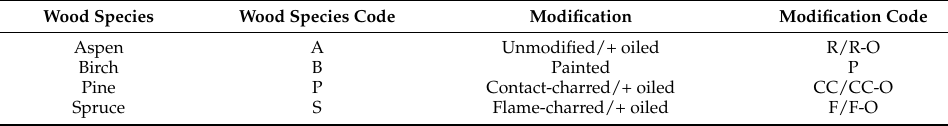
Table 1. Wood species, modifications, and